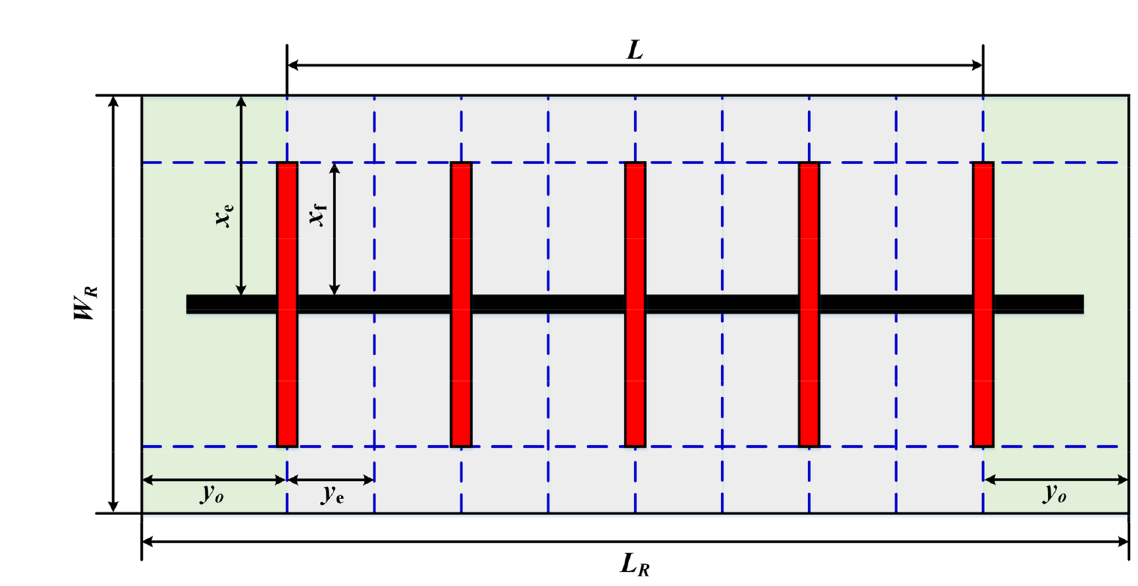
Fig. 2 Schematic of multiple stage fractures in closed